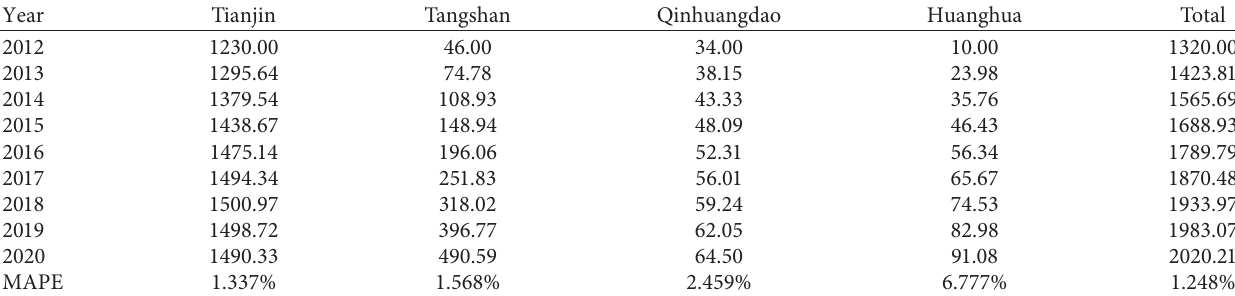
Table 2: FGM (1.1) when r � 0 . 2 container throughput of Tianjin-Hebei Port Group (unit: